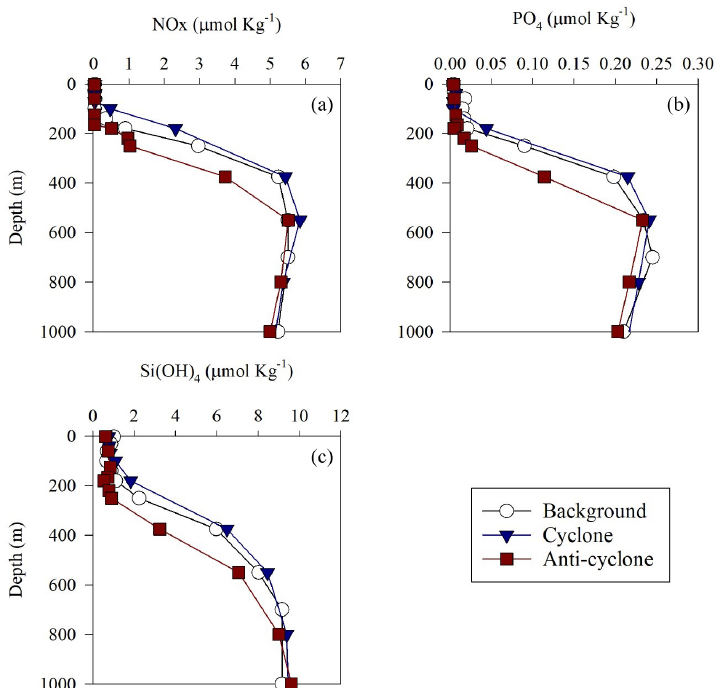
Figure 2. Vertical profile of NO x (a) , PO 3 + (b) and Si ( OH ) 4 (c) in cyclonic (blue triangle) and anticyclonic (red square) eddies and an 4 uninfluenced background station (white circle) in the southeastern Mediterranean Sea during October